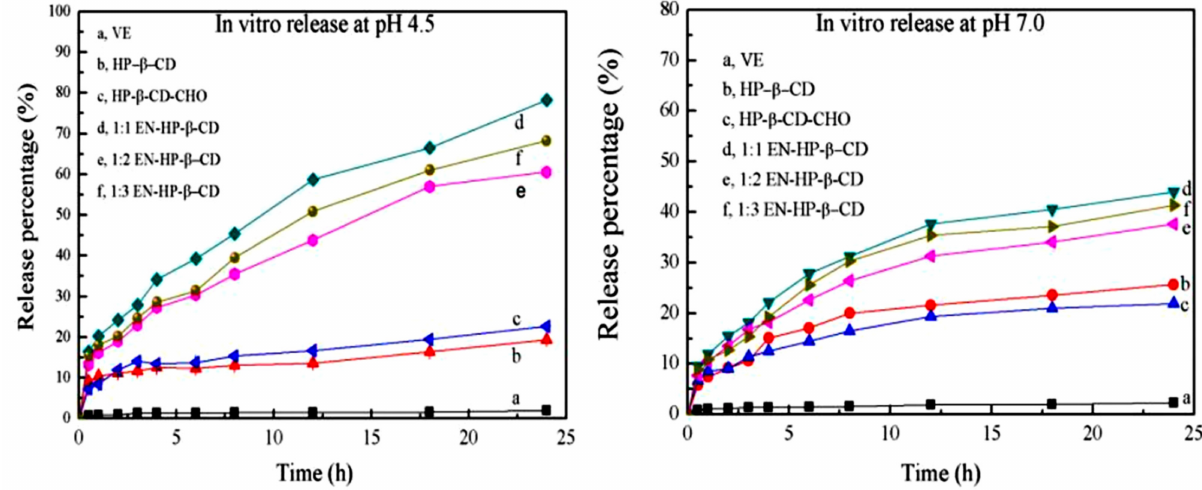
Figure 9. Cumulative release (%) of vitamin E, and its inclusion complexes with HP– β -CD and EN–HP– β -CD at pH 4.5. and pH 7.0 [103]. EN: ethylenediamine, HP: hydroxypropylated